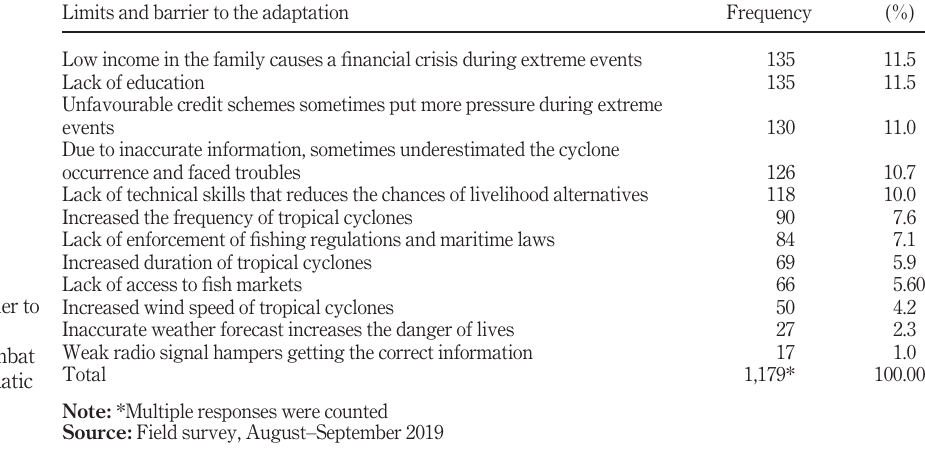
Limits and barrier to the